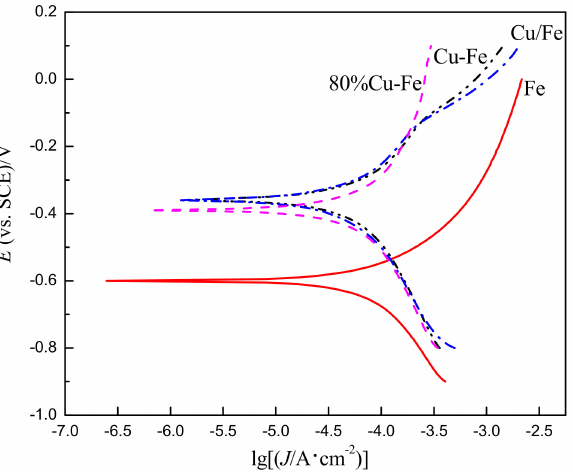
Figure 5. Polarization curves of carbon steel and Cu − Fe alloy in 3.5% NaCl solution. Table 2. Fitting result of polarization curves for carbon steel and Cu − Fe alloy in 3.5% NaCl solution.